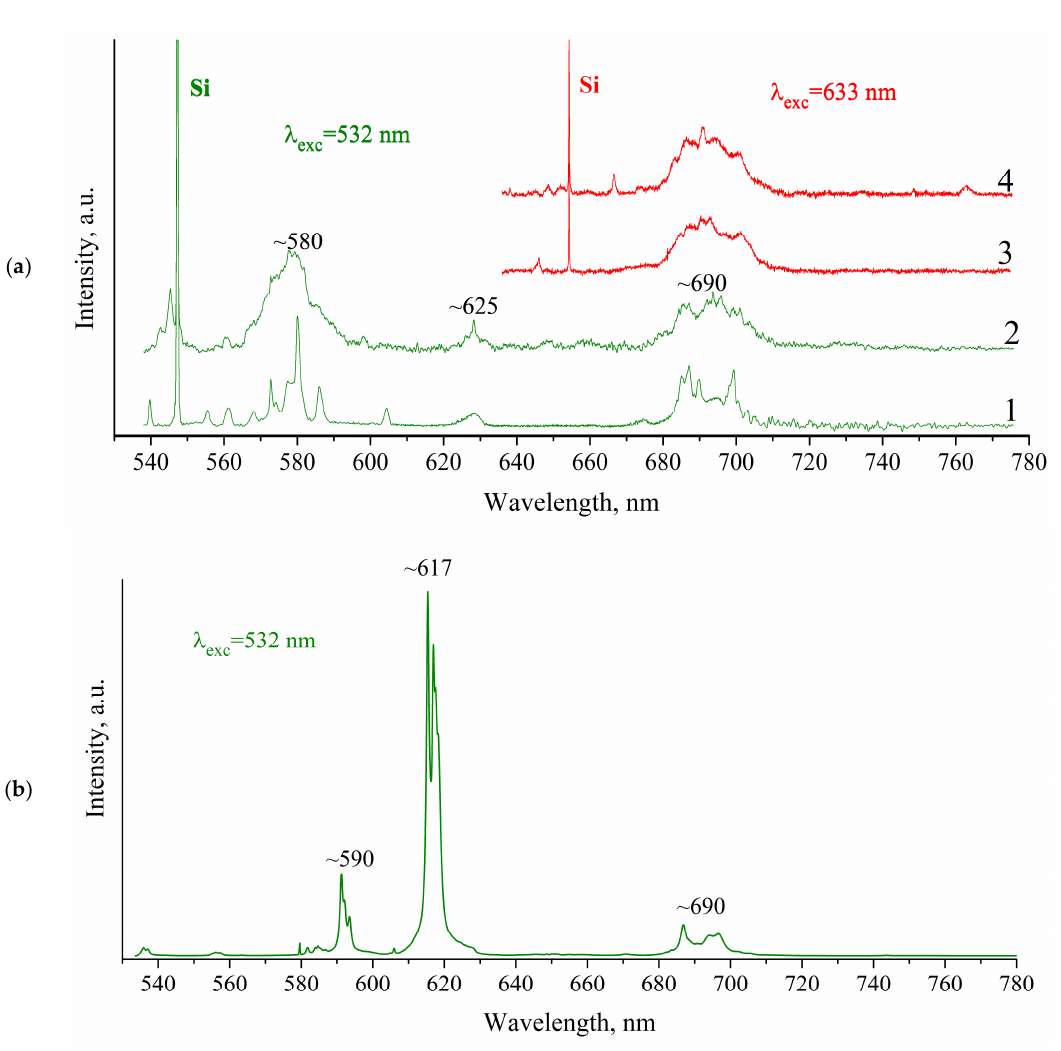
Figure 5. ( a ) Photoluminescence spectra CVD diamond film grown with suspension DND-COO-{Eu} at different excited laser wavelengths: λ exc = 532 nm and λ exc = 633 nm. 1–4—different points on of CVD DND(Eu) surface. ( b ) Photoluminescence spectrum of the europium nitrate powder Eu(NO 3 ) 3 6H 2 O used in preparation of DND-COO-{Eu} particles suspension. The background has been subtracted in both cases. Band ~ 580 nm corresponds to 5 D 0 — 7 F 1 transition, ~625 nm— 5 D 0 — 7 F 2 transition and ~690 nm— 5 D 0 — 7 F 4 transition.